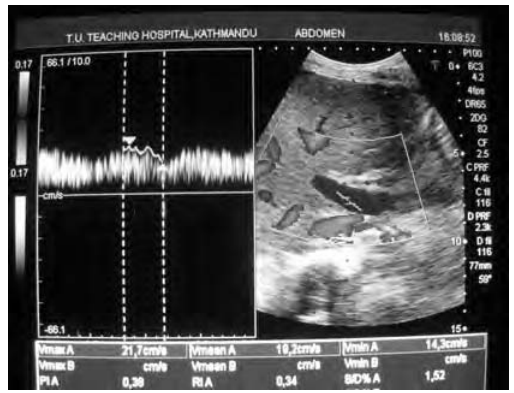
Fig 1. Normal pulsatile portal vein waveform with presence of window below the wave